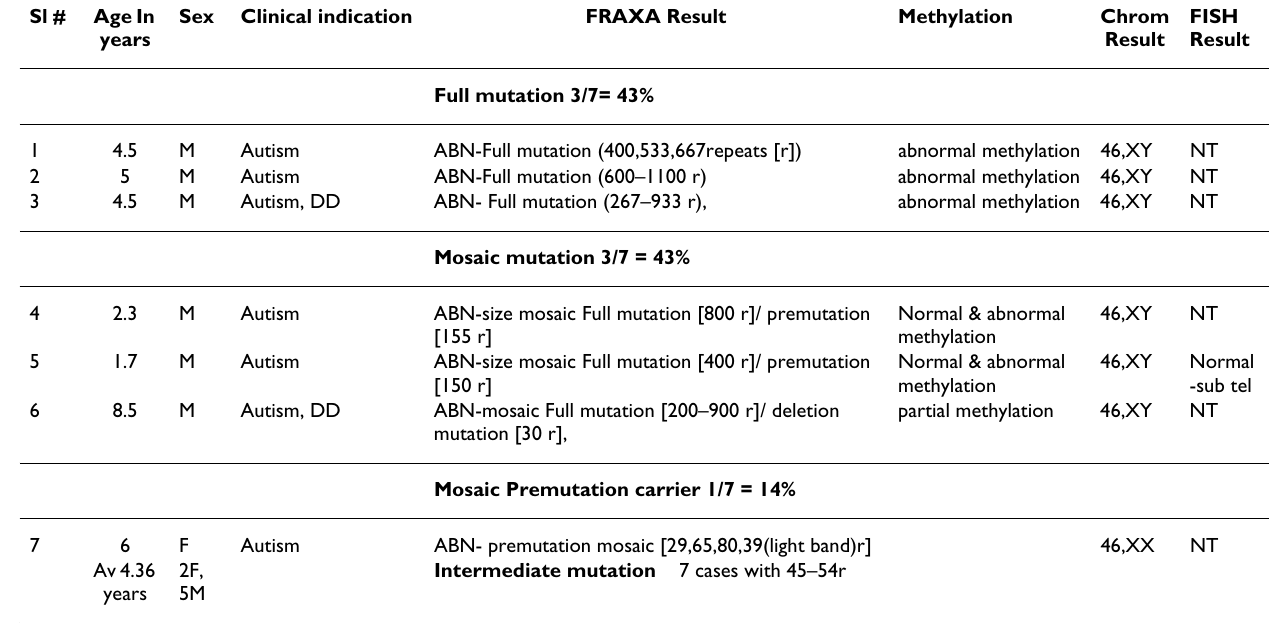
Table 4: The details of Fragile X mutations found in 2.2 % (7/316) patients with a clinical indication of autism Sl